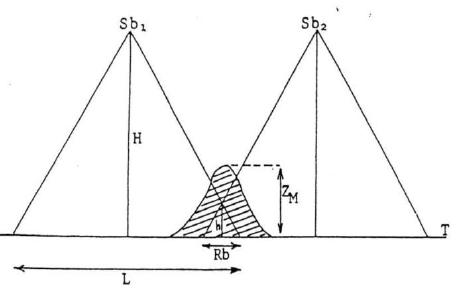
Figure 5: Overlapping problem over non flat terrain.